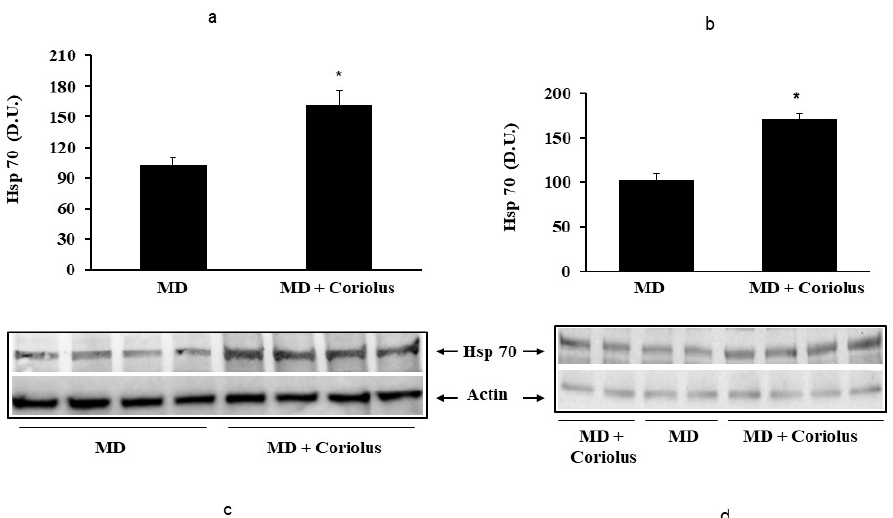
Figure 2. Heat shock protein 70 levels in lymphocytes and in plasma from MD patients. Samples from MD patients were assayed for heat shock protein 70 (Hsp70) by western blot as described in Materials and Methods. A representative immunoblot is shown in ( c , d ). β -actin has been used as loading control. The bar graphs ( a , b ) show the densitometric evaluation and values are expressed as mean ± SEM of independent analyses on 22 patients (MD plus Coriolus biomass) and, respectively, on 18 patients (MD alone), per group. * p < 0.05 vs. MD alone. D.U., densitometric units.